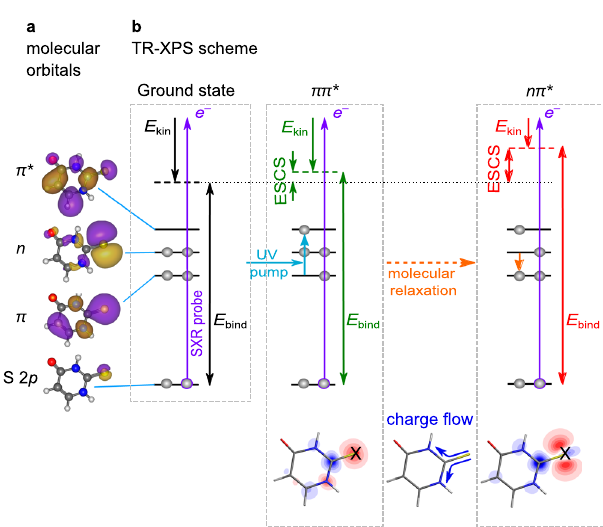
Fig. 1 Schematic picture of TR-XPS and ESCS in 2-thiouracil in a molecular orbital representation. a Molecular valence ( π , n , π * ) orbitals and a core (sulphur 2 p ) orbital. b Probe of the S 2 p core level with a binding energy E bind by means of a soft x-ray (SXR) light pulse, leading to a photoelectron with a kinetic energy, E kin . A UV pump pulse (cyan arrow) excites the 2-thiouracil from its electronic ground state (S 0 ) to a ππ * state (S 2 ) which then relaxes further, for instance into the S 1 ( n π * ) state shown here. The difference in E bind with respect to the ground state is the excited- state chemical shift ð ESCS ¼ E excited state bind structures in the lower part of the panel represent the difference in charge density between the ground state and the respective excited states (red: decreased electron density, blue: increased electron density). Increase in positive charge at the sulphur site (marked with X) increases E bind and the